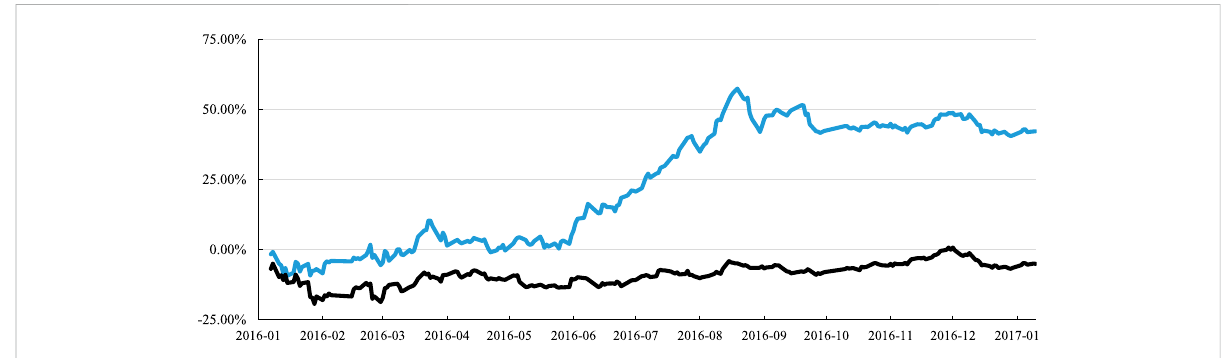
FIGURE 5 Back-testingof thestrategy considering thecurrent collective investor attention. Thehorizontal axisisthedate, andthevertical axisrepresents the return of the strategy. The black line is thereturn of HS300 as a benchmark, and the blue line is the return of thestrategy considering thecurrent collective investor